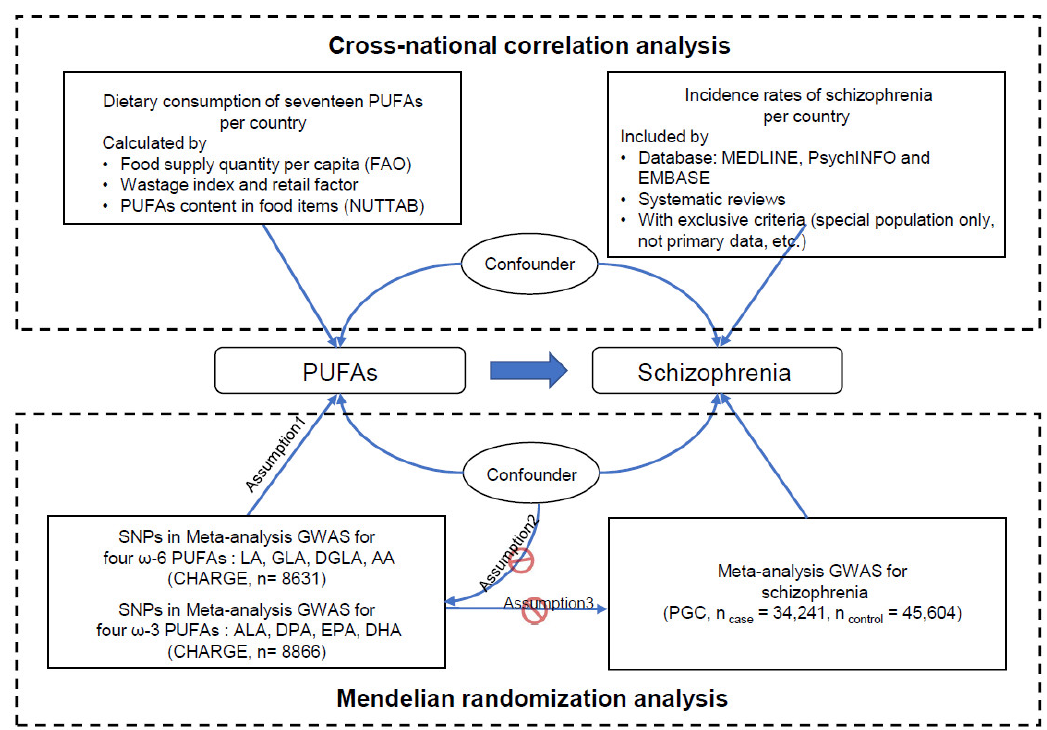
Figure 1. Schematic diagram of our study design. PUFA—polyunsaturated fatty acid; FAO—Food and Agriculture Organization of the United Nations; NUTTAB—Australian Food Composition Da- tabase (previously called NUTTAB); GWAS—genome-wide association study; SNP—single-nucle- otide polymorphism; CHARGE—Cohorts for Heart and Aging Research in Genomic Epidemiology;